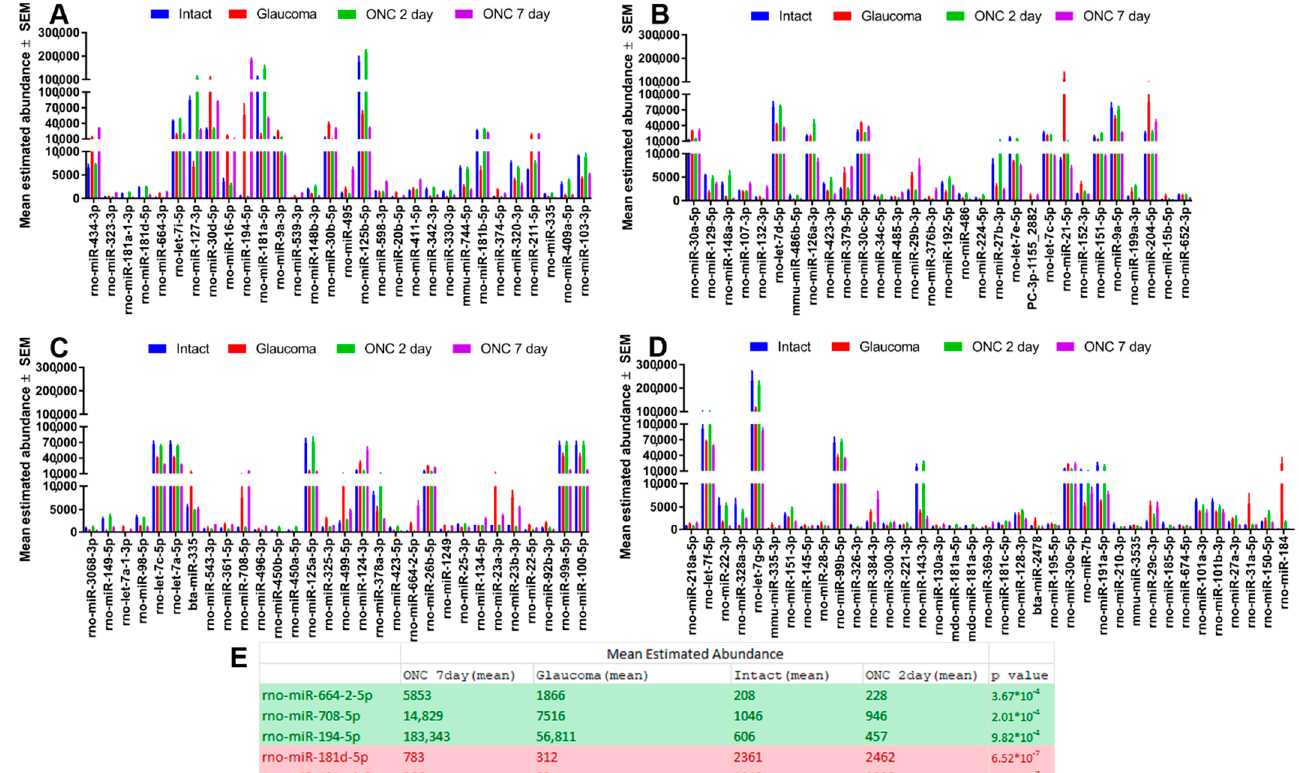
Figure 3. miRNA abundance profile. Histograms displaying the average abundance values for the miRNA detailed in Figure 2. (miRNA significantly different between the RGC of healthy and diseased retina). miRNA are displayed in the same order as in Figure 2, starting with those that are the most significantly different ( A – D ). The five candidate miRNA that were further tested for their neuroprotective efficacy are included in the table ( E ) along with their respective abundance counts. Those in green demonstrated an increase in abundance after injury, whereas those in red demonstrated a decrease.